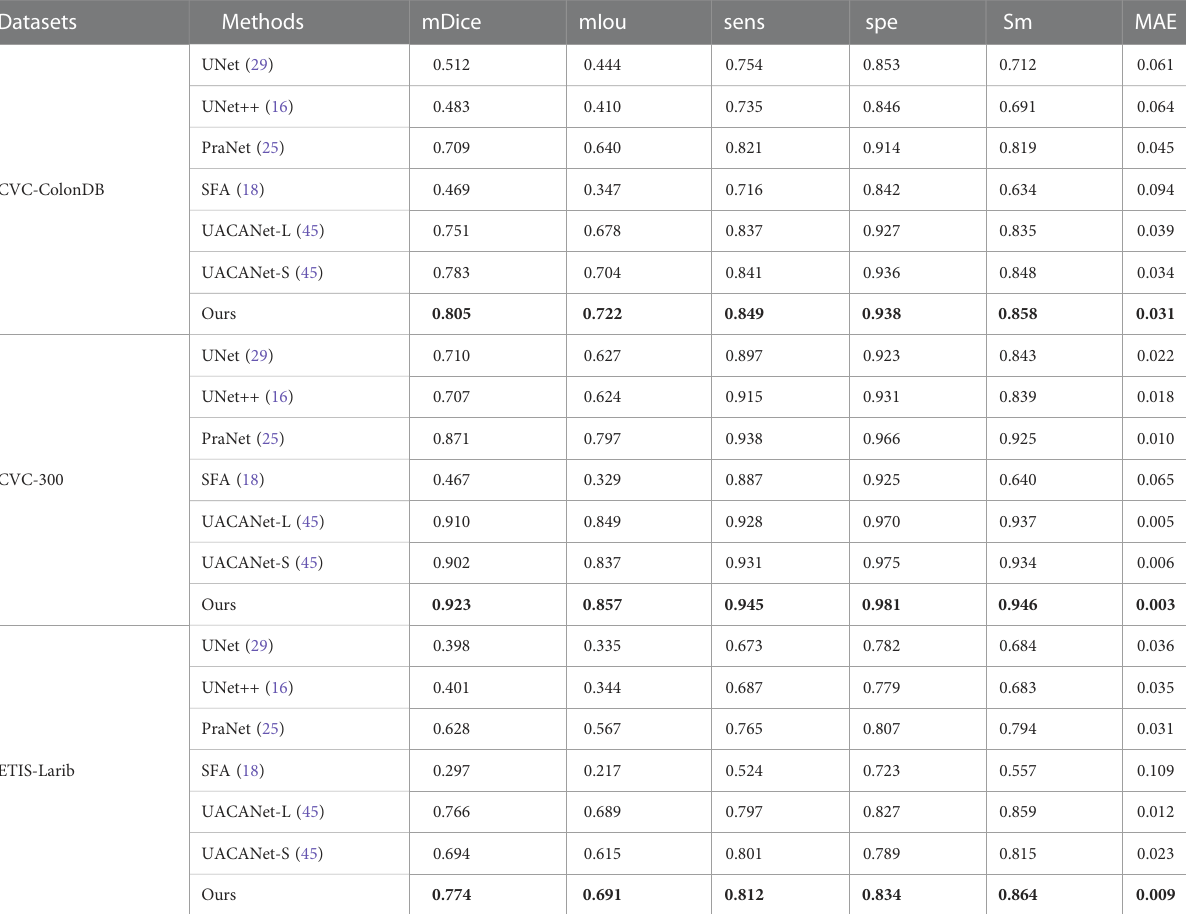
TABLE 3 Comparison results of different methods on an unseen dataset.